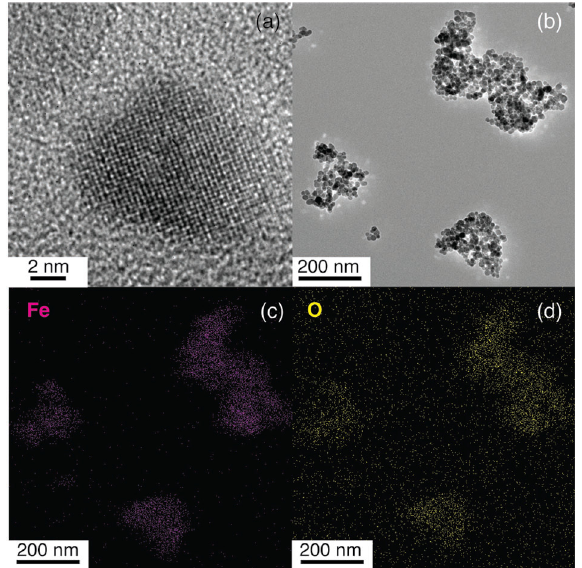
Figure 1. TEM images and EDS mapping images of EMG1111 magnetic nanoparticles. ( a ) TEM image of isolated magnetic nanoparticles; ( b) TEM image of magnetic nanoparticles; ( c ) EDS mapping image of iron corresponding to image (b); ( d ) EDS mapping image of oxygen corresponding to image